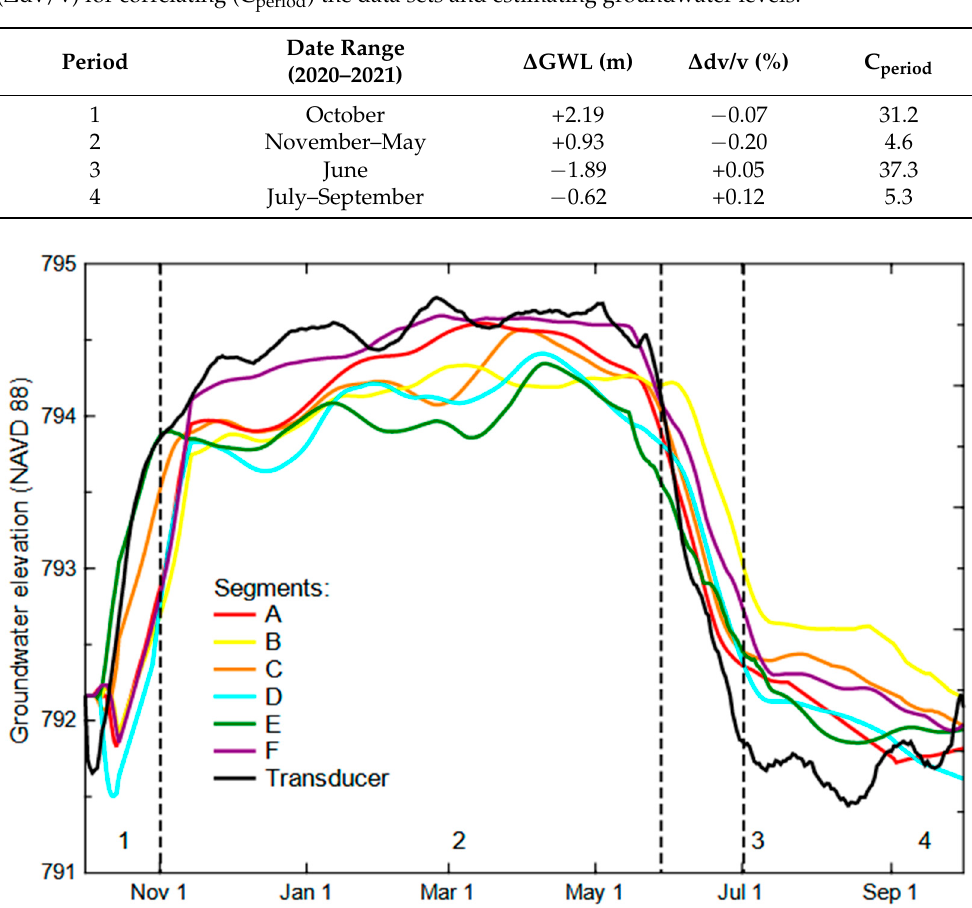
Figure 7. Groundwater elevations derived from dv/v for each network segment (Figure 5) compared to the groundwater elevation measured by the well transducer. Temporal periods (1–4) were seasonal divisions used to develop correlations between dv/v and groundwater changes. Table 3. Seasonal periods and associated changes in groundwater ( Δ GWL) and seismic wave veloc- ity ( Δ dv/v) for correlating (C period ) the data sets and estimating groundwater levels.